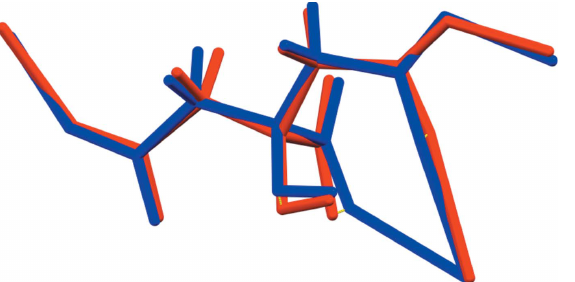
Figure 2 Comparison of the refined and optimized structures of Li 2 KC 6 H 5 O 7 . The refined structure is in red, and the DFT-optimized structure is in blue.